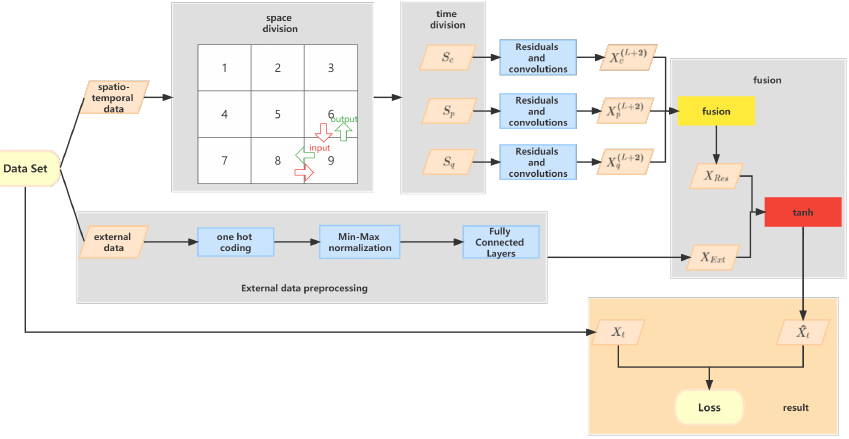
Figure 7. Comprehensive flow chart of electricity sales forecasting based on